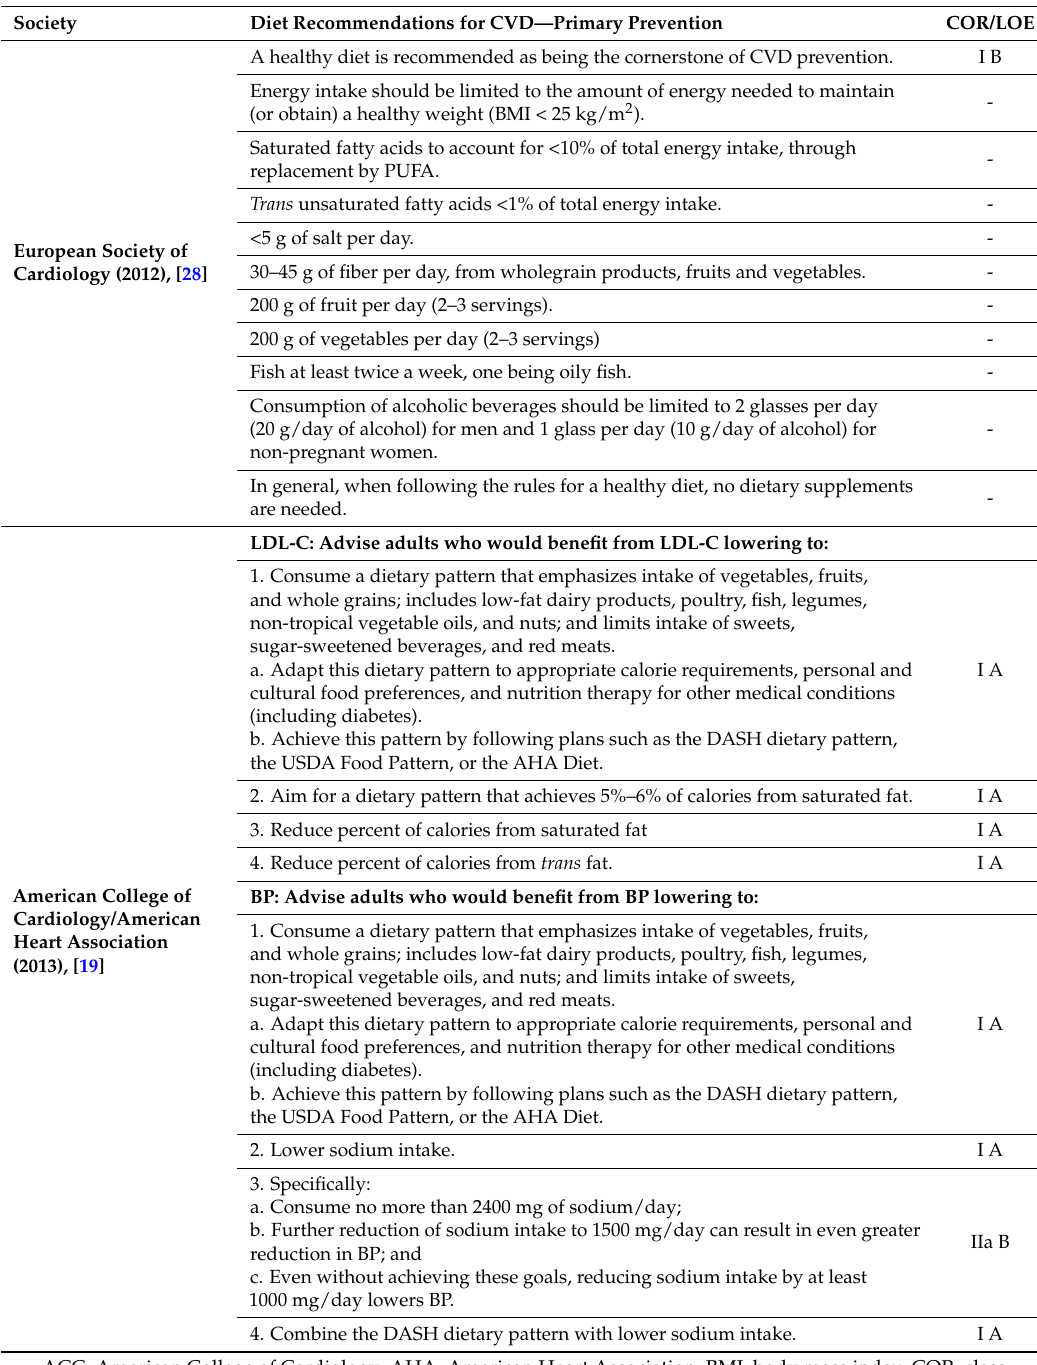
Table 3. ESC and ACC/AHA dietary recommendations for risk factor management and primary prevention of CVD.